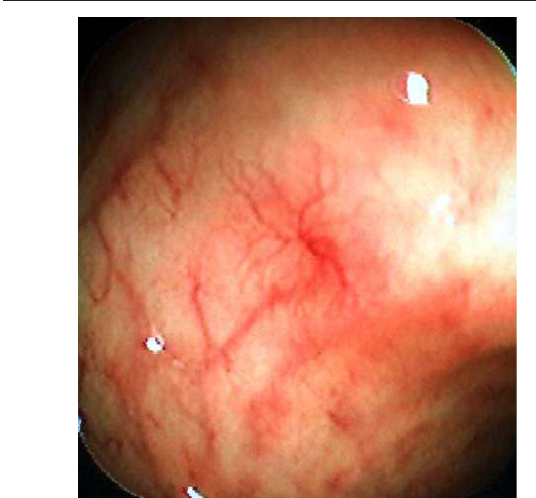
FIGURE 1 - Colonoscopic view of hyperemia of the colonic mucosa(GI).